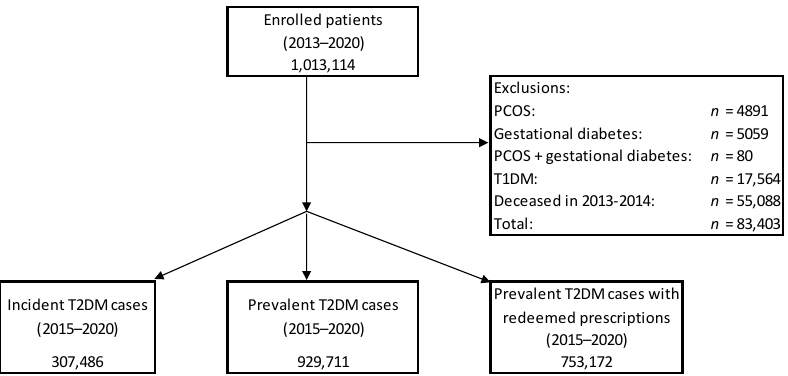
Figure 1. Flow-chart of the analysis (T1DM: type 1 diabetes mellitus, T2DM: type 2 diabetes mellitus, PCOS: polycystic ovary syndrome). The incidence cases of T2DM continuously decreased from 2015 to 2019 but a greater decrease was observed thereafter, in 2020. On the other hand, prevalent cases steadily increased from 2015 to 2019 while there was a small decrease in 2020 (crude numbers in 2015: n = 682,274; in 2019: 760,032; in 2020: n = 752,367). The numbers of prevalent T2DM patients with redeemed prescriptions were about 20% smaller each year, compared to the number of total prevalent cases (Table 1). Table 1. Patients with type 2 diabetes mellitus (T2DM): incident and prevalent cases (crude num- bers) in the central database between 2015 and 2020 (reference period: 2013 – 2014). Incident Cases ( n ) Prevalent Cases ( n )